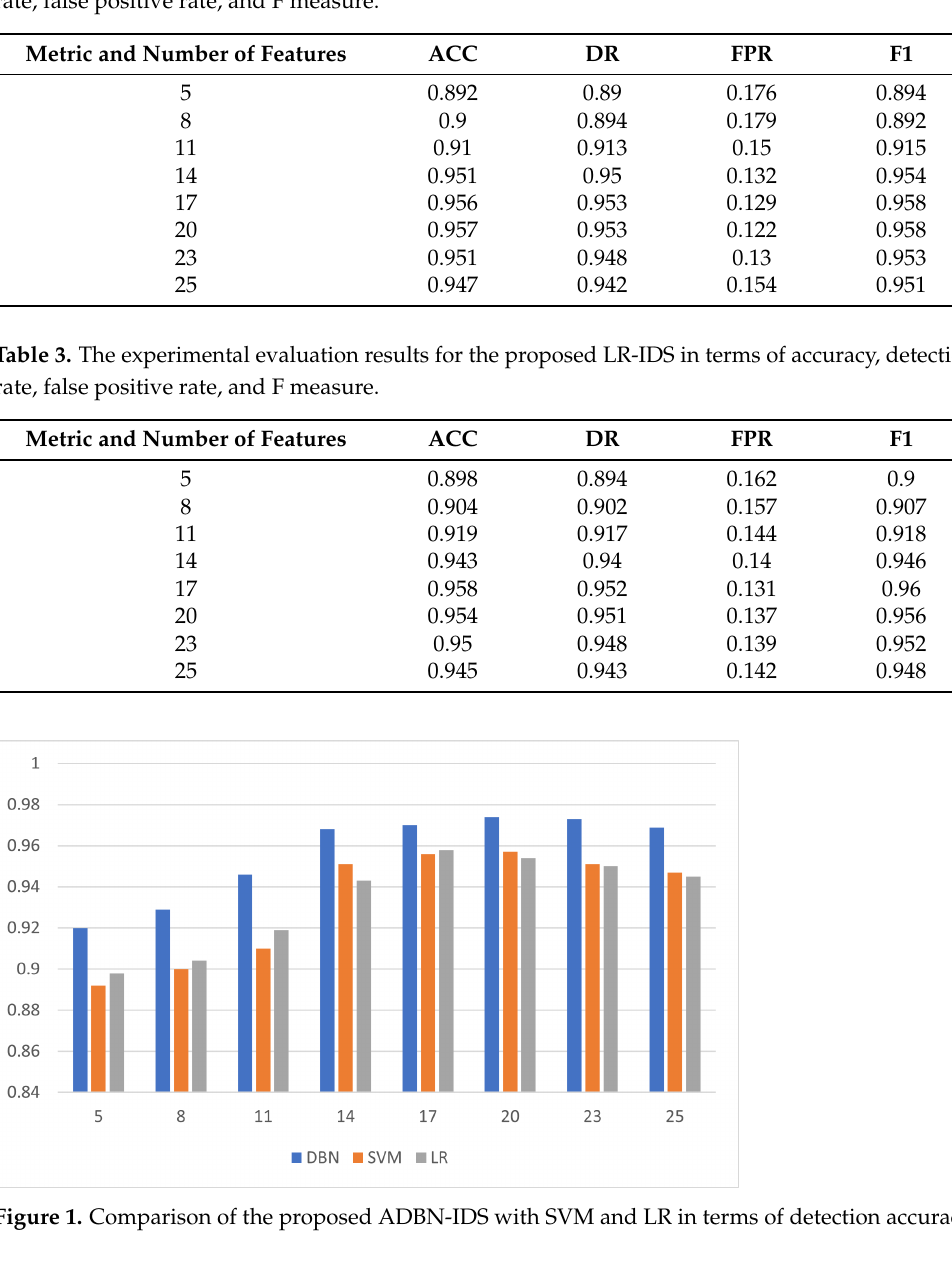
Table 2. The experimental evaluation results for the proposed SVM-IDS in terms of accuracy, detection rate, false positive rate, and F measure.